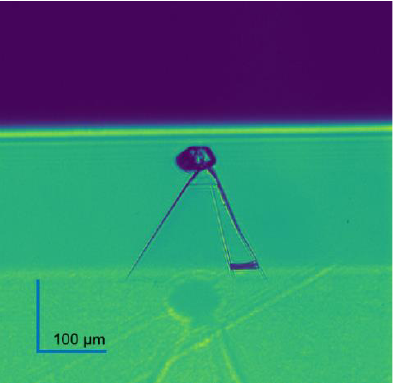
Fig. 1 Ellipsometric microscope image of a triangular defect on 12 μm 4H-SiC epilayer grown on 4H-SiC substrate In the detected defect (Fig. 1) the spherical and triangle areas can be distinguished. The spherical area is reported to be caused by the landing of particles during the epitaxy process [4]. In the triangular area terrace-like structures are formed [4]. Using Raman spectroscopy, it was